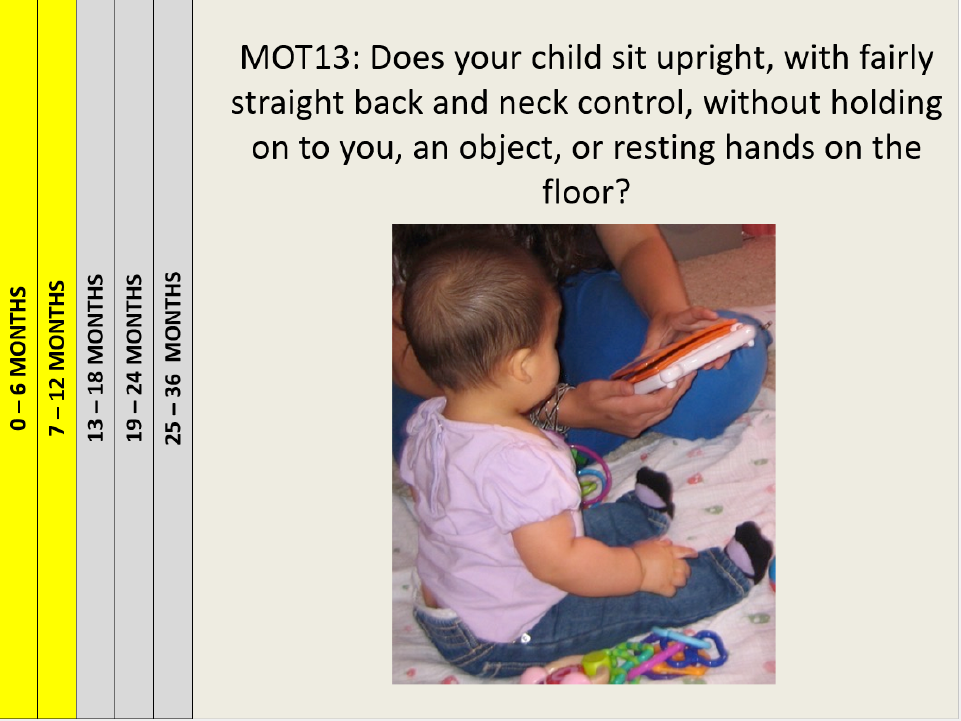
Figure 2. Example of items with prompts.